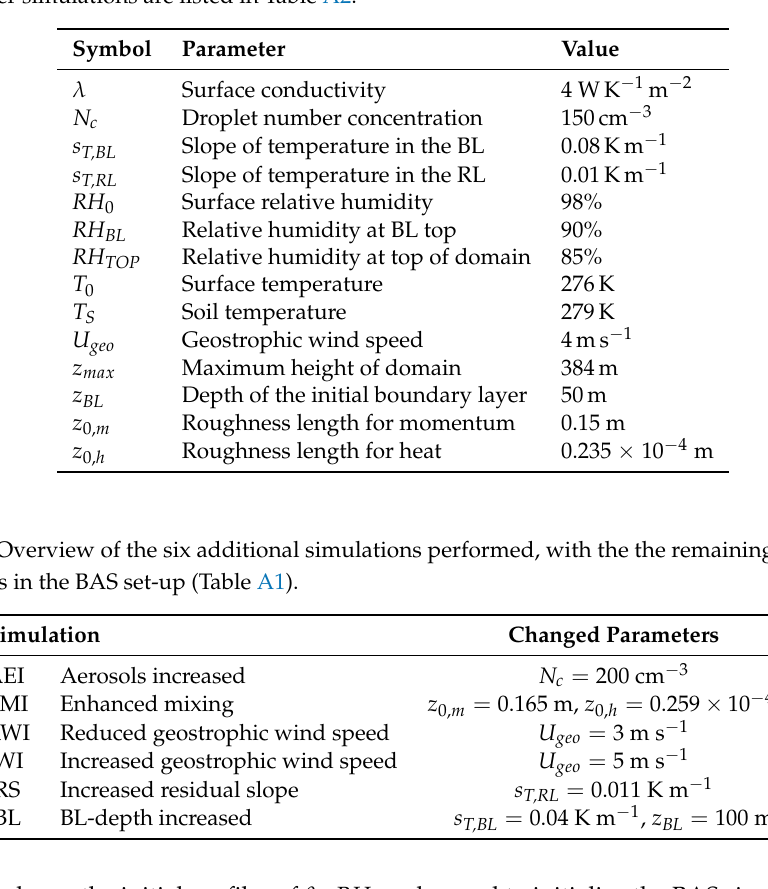
Table A1. Overview of the main parameters used to initialize the BAS simulation. Parameters modified for the other simulations are listed in Table A2.